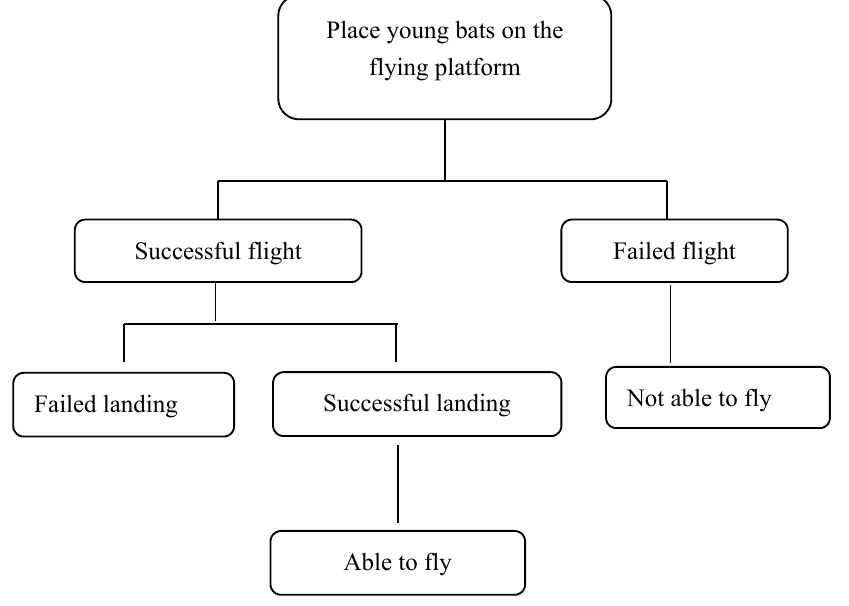
Figure 2. Schematic diagram of the flight experiment equipment.